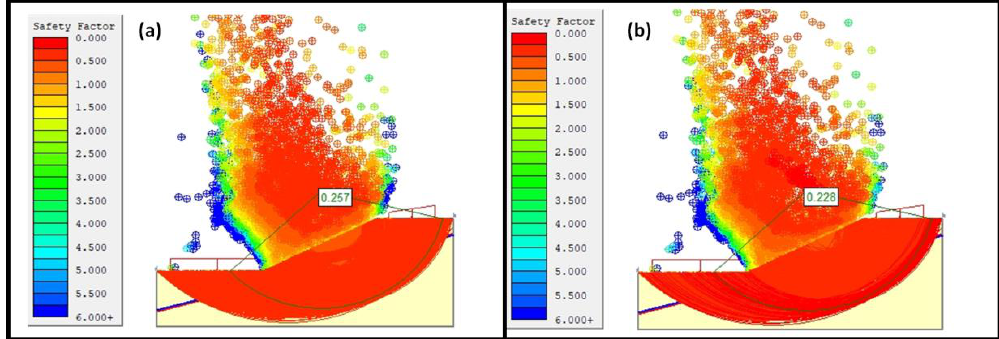
Figure 27. Safety factor simulated for drained to undrained conditions in clay loam soil slope using ( a ) Bishop’s simplified method and ( b ) Janbu’s simplified method.